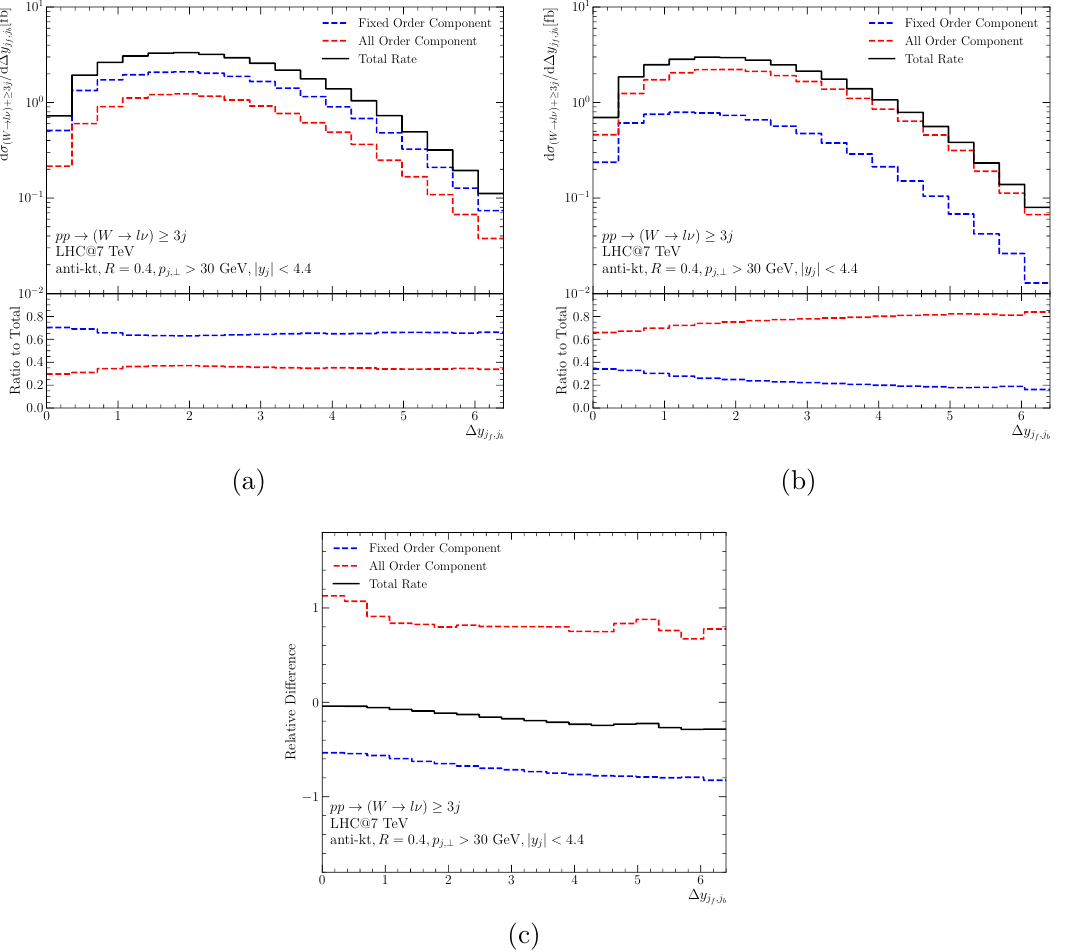
Figure 12. The differential distribution (black, solid) in the rapidity difference between the most- forward and most-backward jets, ∆ y , in pp → ( W → ‘ν )+ ≥ 3 j , for (a) case 1, where re- j f ,j b summation is applied only to LL states, and (b) case 2, where resummation is applied to all LL and NLL states. Also shown in each case is the breakdown into the component where all-order resummation is applied (red, dashed) and the component which remains described at fixed-order only (blue, dashed). The relative change in each line is shown in (c), using the procedure described in the